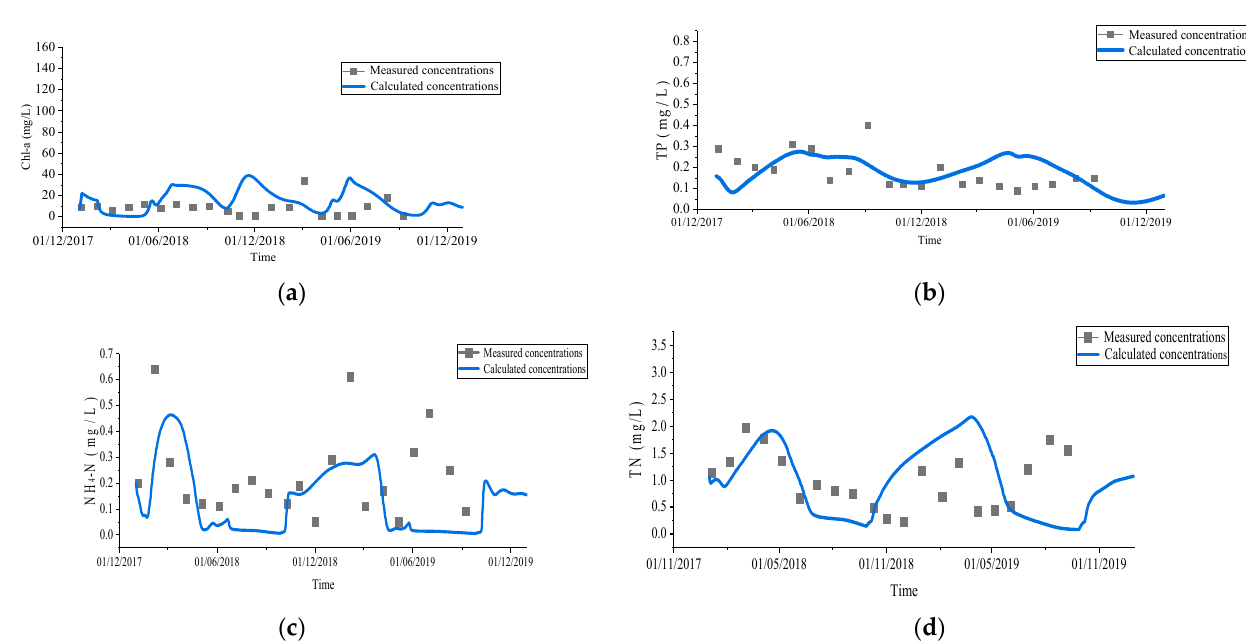
Figure 6. Calibration results for the simulated (blue lines) and measured (brown squares) values of the water quality parameters in Lake Datong: ( a ) chlorophyll a (Chl- a ), ( b ) total phosphorus (TP), ( c ) ammonium nitrogen (NH 4+ -N), and ( d ) total nitrogen (TN).